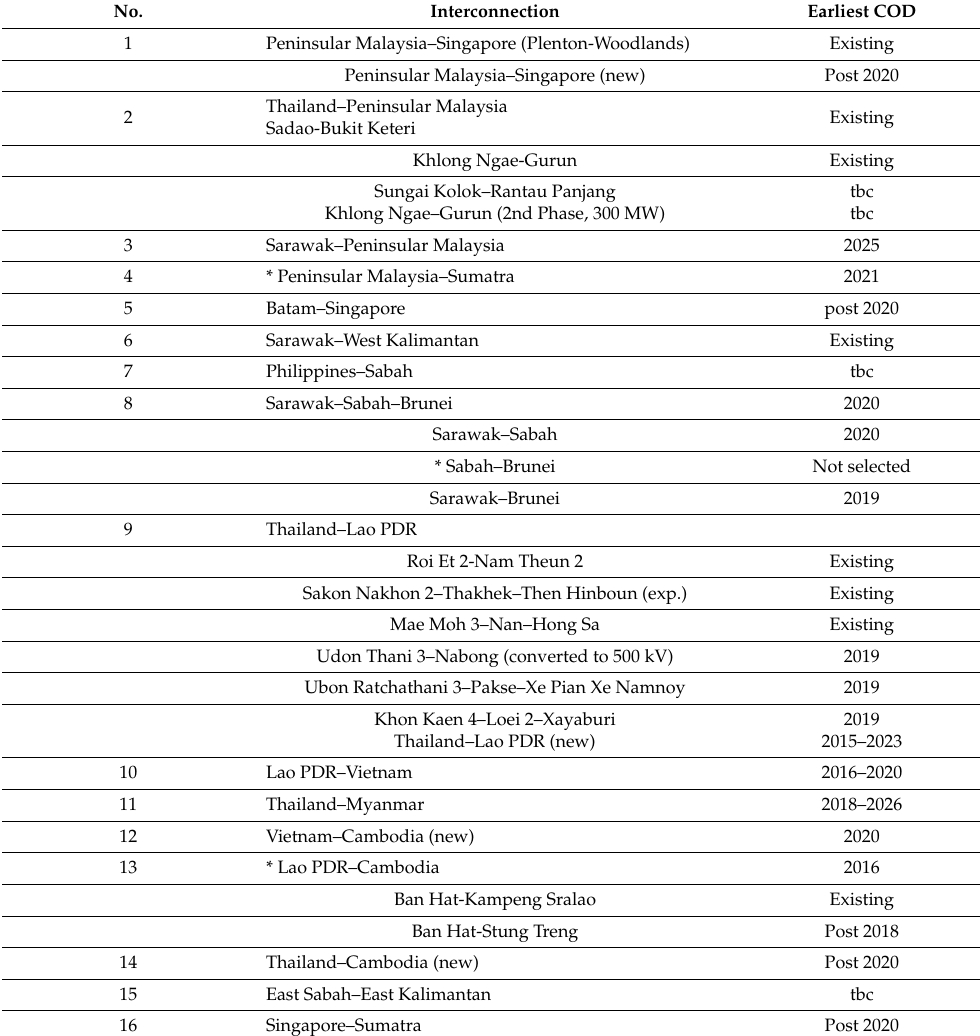
Table 4. ASEAN Power Grid (APG) Interconnections (as of May 2017) [51,52]. No. Interconnection Earliest